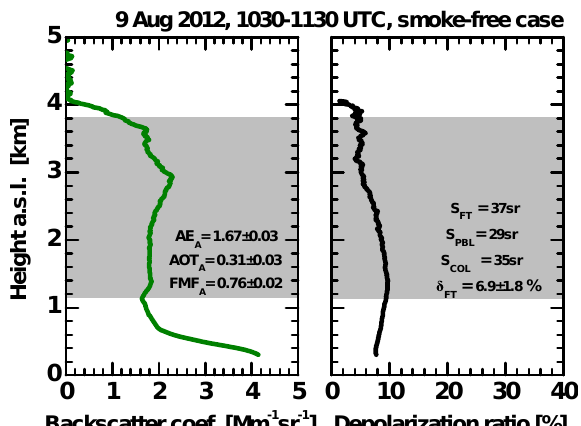
Figure 3. Six-day HYSPLIT backward trajectories arriving at Li- massol, Cyprus, at different height levels (black, blue, light blue, green, orange, yellow) on 9 August 2012, 12:00UTC. Red crosses indicate fire events which occurred during the time period from 2 to 9 August 2012 according to MODIS